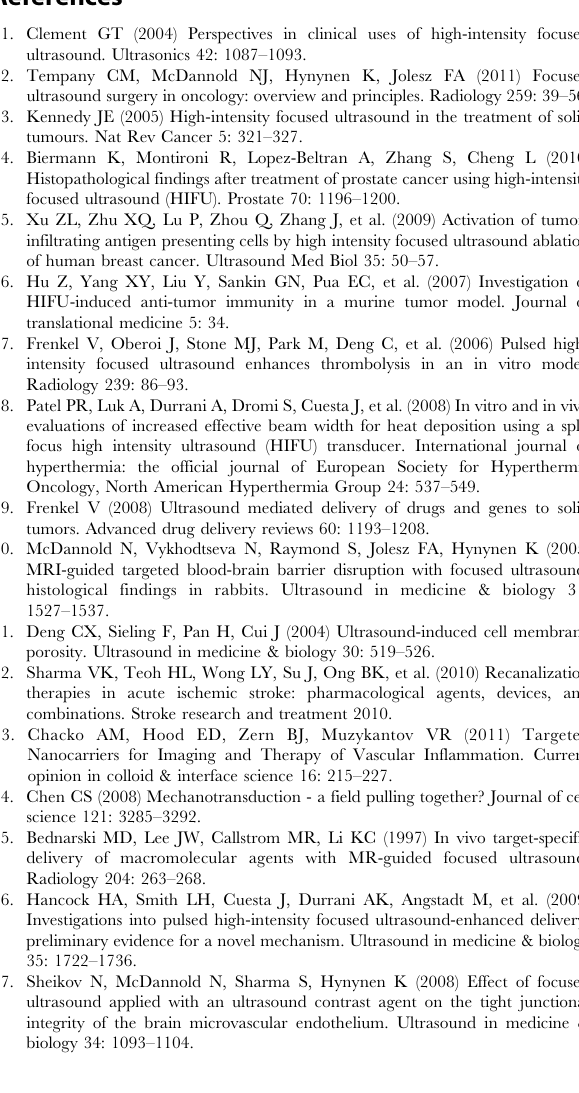
Table S1 Statistical analysis of cytokine array data following cFUS or pFUS. Table S2 Statistical analysis of expression of growth factors following